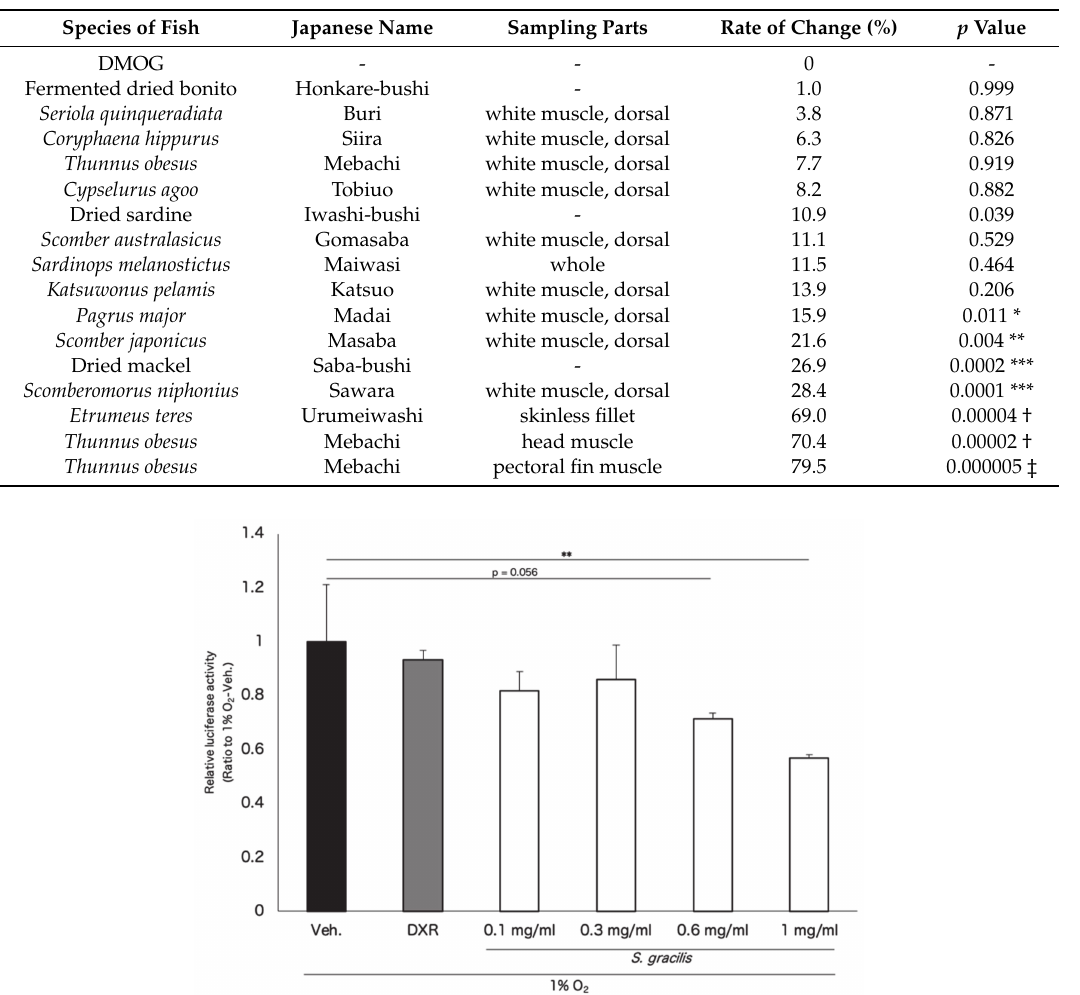
Table A3. The list of fishes showing no HIF inhibitory e ff ect in the second screening with statistical analysis and the rate of change of HIF activity compared with DMOG-administrated controls ( n = 3).